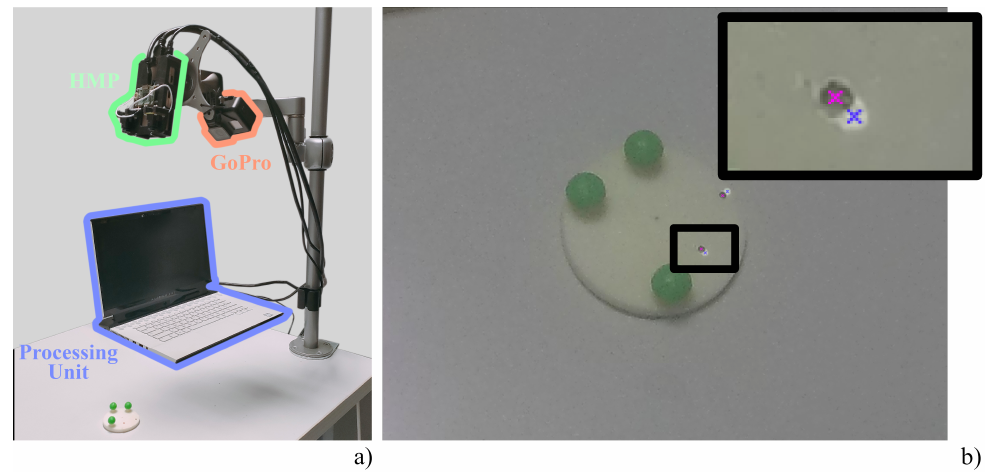
Figure 1. Spatial registration. ( a ) Set-up for evaluation of spatial registration consisting of the HMP (green) and the GoPro Hero 5 (orange), both placed on a holder for working depth selection, the processing unit (blue), and the spatial registration evaluation tool. ( b ) Zoom of an image captured by the GoPro Hero 5: pink crosses denote the real reference points, whereas blue crosses denote the projected